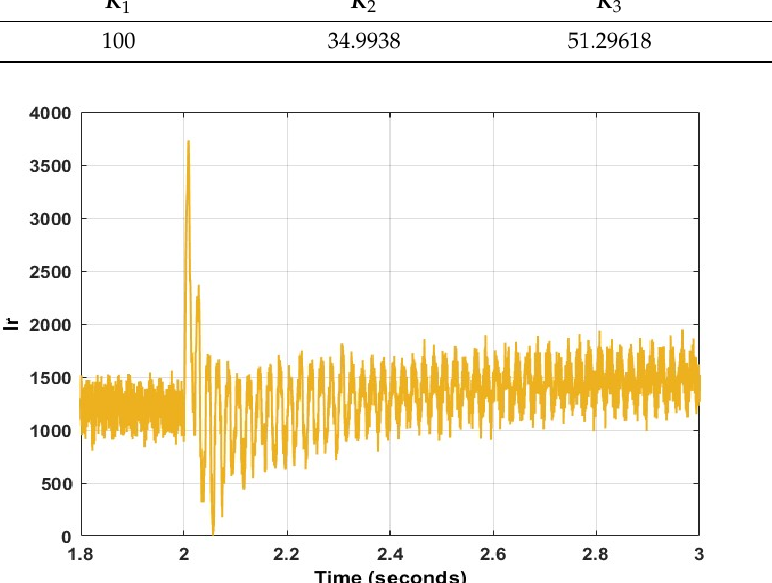
Figure 29. Rotor current transient using LQR at 70% dip.